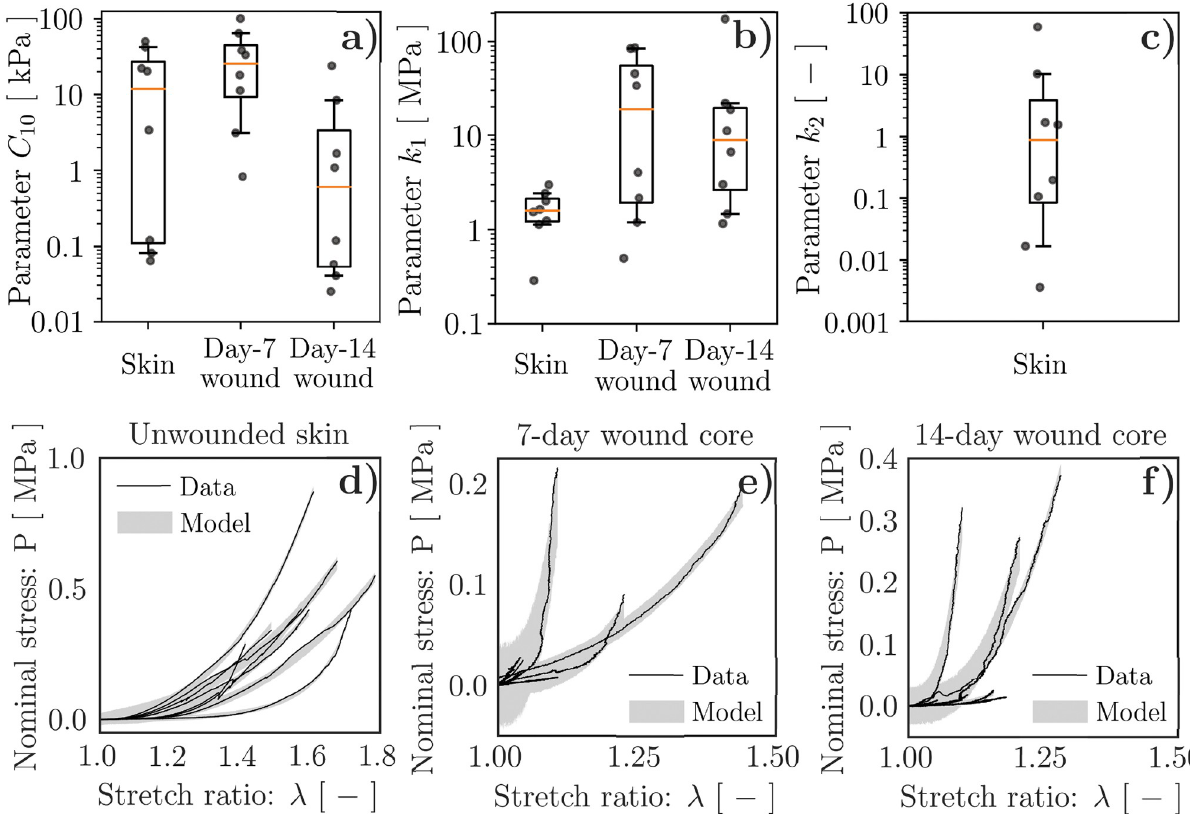
Fig 4. Hierarchical Bayesian calibration of tissue mechanical parameters. ( a ) C 10 , corresponding to the behavior of the non-collagenous ground substance, exhibits marked decrease between 7- and 14-days post-wounding, while mostly remaining within the broad range of values characterizing unwounded skin. ( b ) k 1 , corresponding to the behavior of the tissue collagenous matrix, tends to decrease between 7- and 14-days post-wounding, and is typically larger in the wounds than in unwounded skin. ( c ) k 2 , relating to the large deformation behavior of the tissue collagenous matrix, can only be inferred for unwounded skin due to the limited deformability of wounded tissues prior to failure. ( d – f ) Model-based predictions of the specimen tensile behavior accounting for experimental uncertainty. The dots in ( a – c ) indicate median values of the parameter posteriors for each of the N specimens, cf. S2, S3 and S4 Figs. The boxplots in ( a – c ) are constructed based on the values indicated by the dots, with orange lines denoting the median and extension of the whiskers denoting the 95% CI. The shadings in ( d – f ) indicate the 95% CI obtained from 1 0 000 random tensile curves generated using the calibrated Bayesian model and accounting for experimental